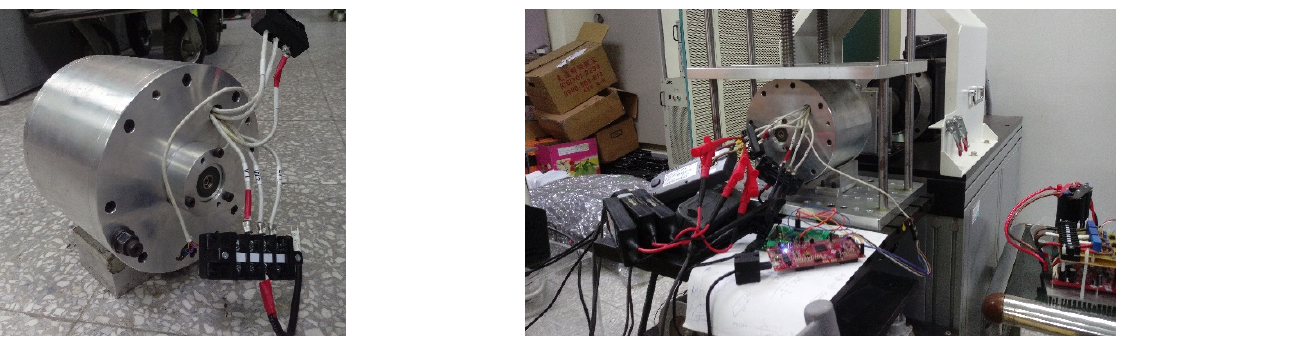
11 of 17 Figure 11. Comparison of torque density between FI-PMa-SynRM and Modified SynRM. 5. Experiment Results The experimental setup for evaluation, measured current waveforms of the devel- oped FI-PMa-SynRM prototype, current harmonics, and torque comparison are shown in Figures 12–15, respectively. In Figure 14, the fundamental frequency is 42 Hz. Because of the limitation of the power source and measurement devices in our laboratories, the de- veloped FI-PMa-SynRM is only measured up to 32.5 A, where the total harmonic distor- tion (THD) of the motor current is around 13.04%. The torque production of the developed FI-PMa-SynRM for the measurement and simulation are compared and presented in Figure 15. As can be seen, the two cases agree well. On the other hand, the simulation results of the modified SynRM are added to compare with the developed FI-PMa-SynRM. As depicted in Figure 15, with a small current angle (about − 55 degrees), the torque pro- duction of the Modified SynRM is only slightly smaller than that of the FI-PMa-SynRM,